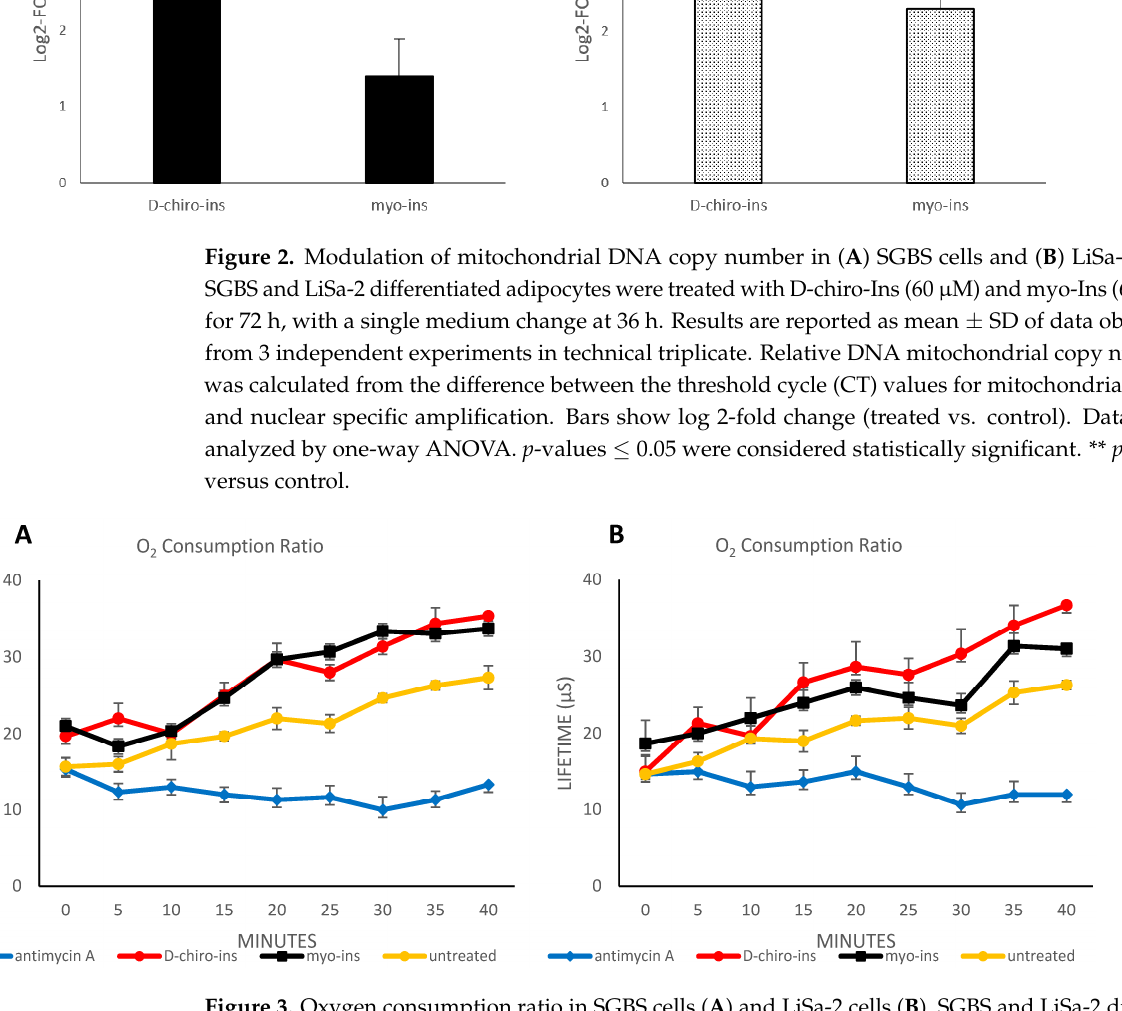
Figure 3. Oxygen consumption ratio in SGBS cells ( A ) and LiSa-2 cells ( B ). SGBS and